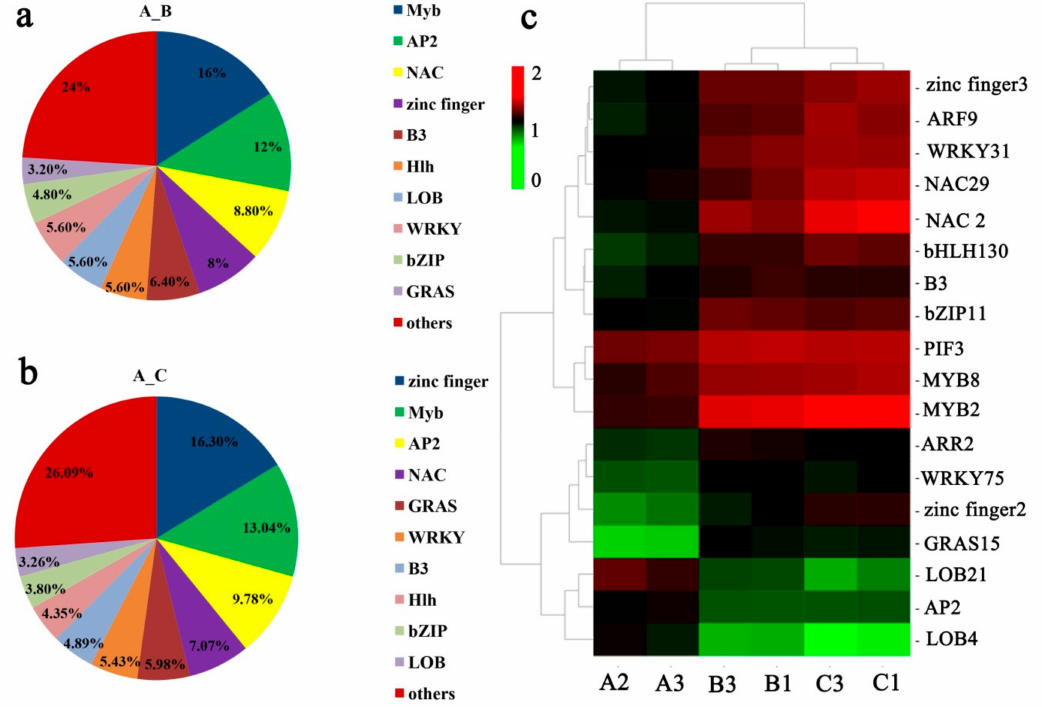
9DEGs of CBL-interacting STPK, and 10 DEGs of G-type lectin S-receptor-like STPK.